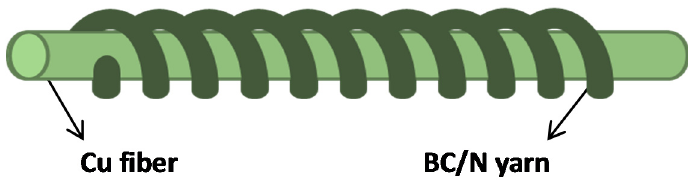
Figure 1. Schematic diagram of Bamboo ‐ charcoal/nylon/Copper (BC/N/Cu) wrap yarn.